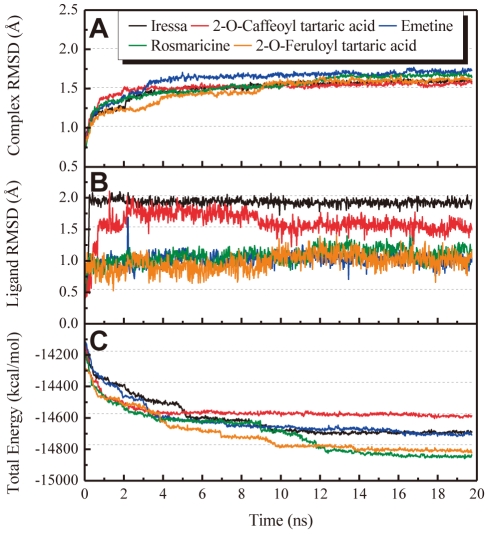
RMSD and total energy during MD simulation.(A) Protein-ligand complex RMSD (Å), (B) ligand RMSD (Å) and (C) total energy of protein-ligand complex.